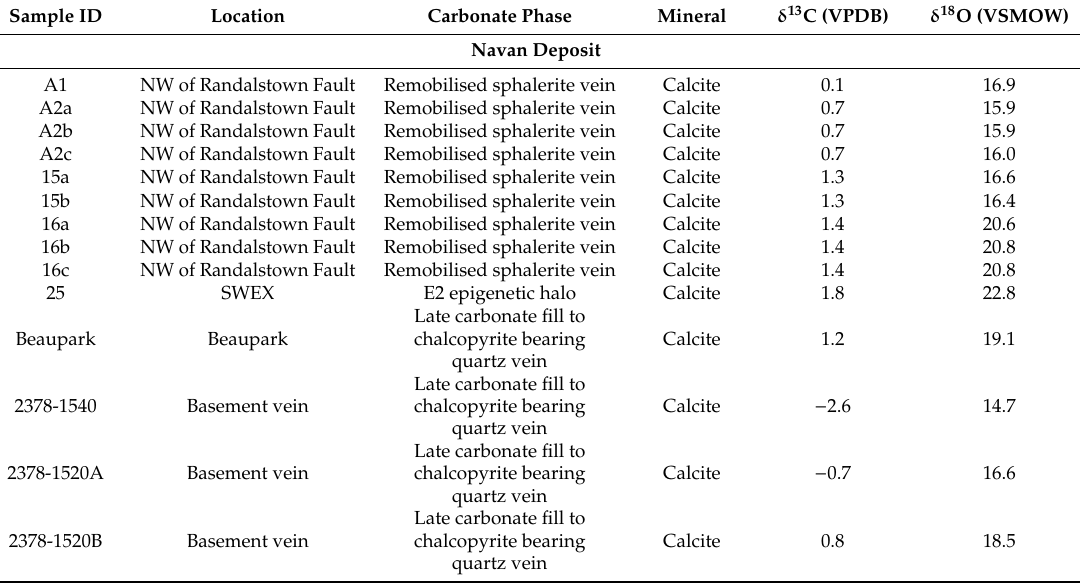
Table A2. C–O isotope data from Navan and Lisheen